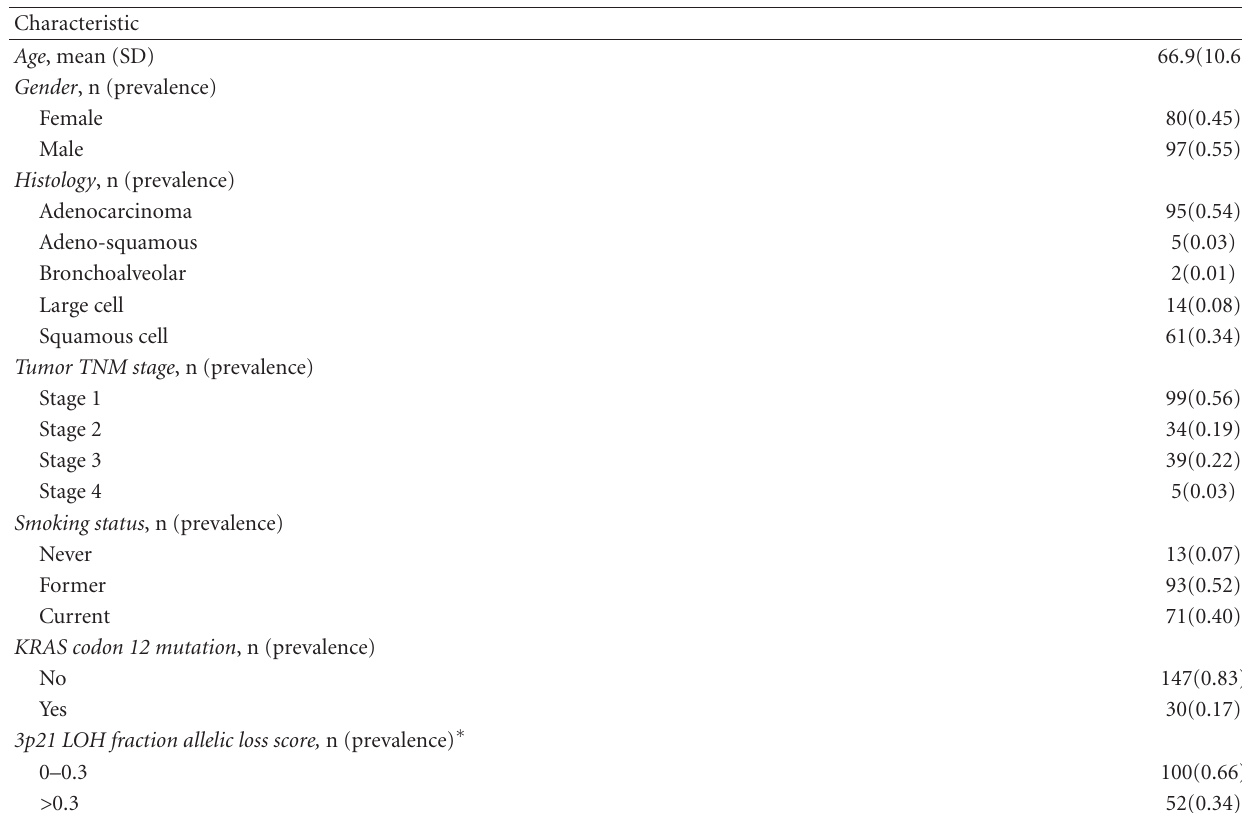
Table 1: Demographics of the NSCLC case